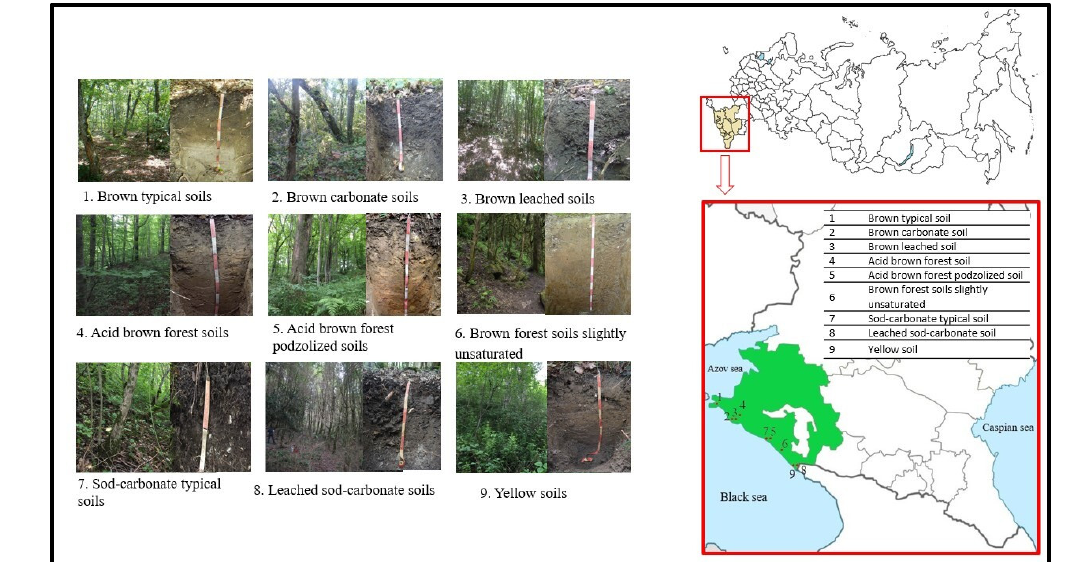
Figure 1. Selection sites for different soil